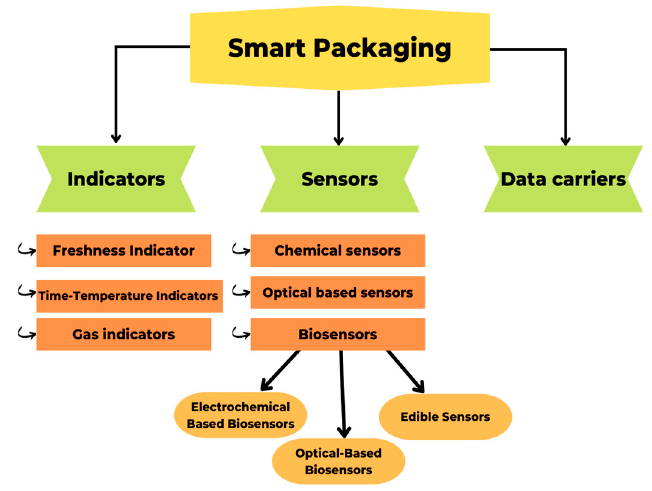
Figure 5. Types of smart packaging and its categories.